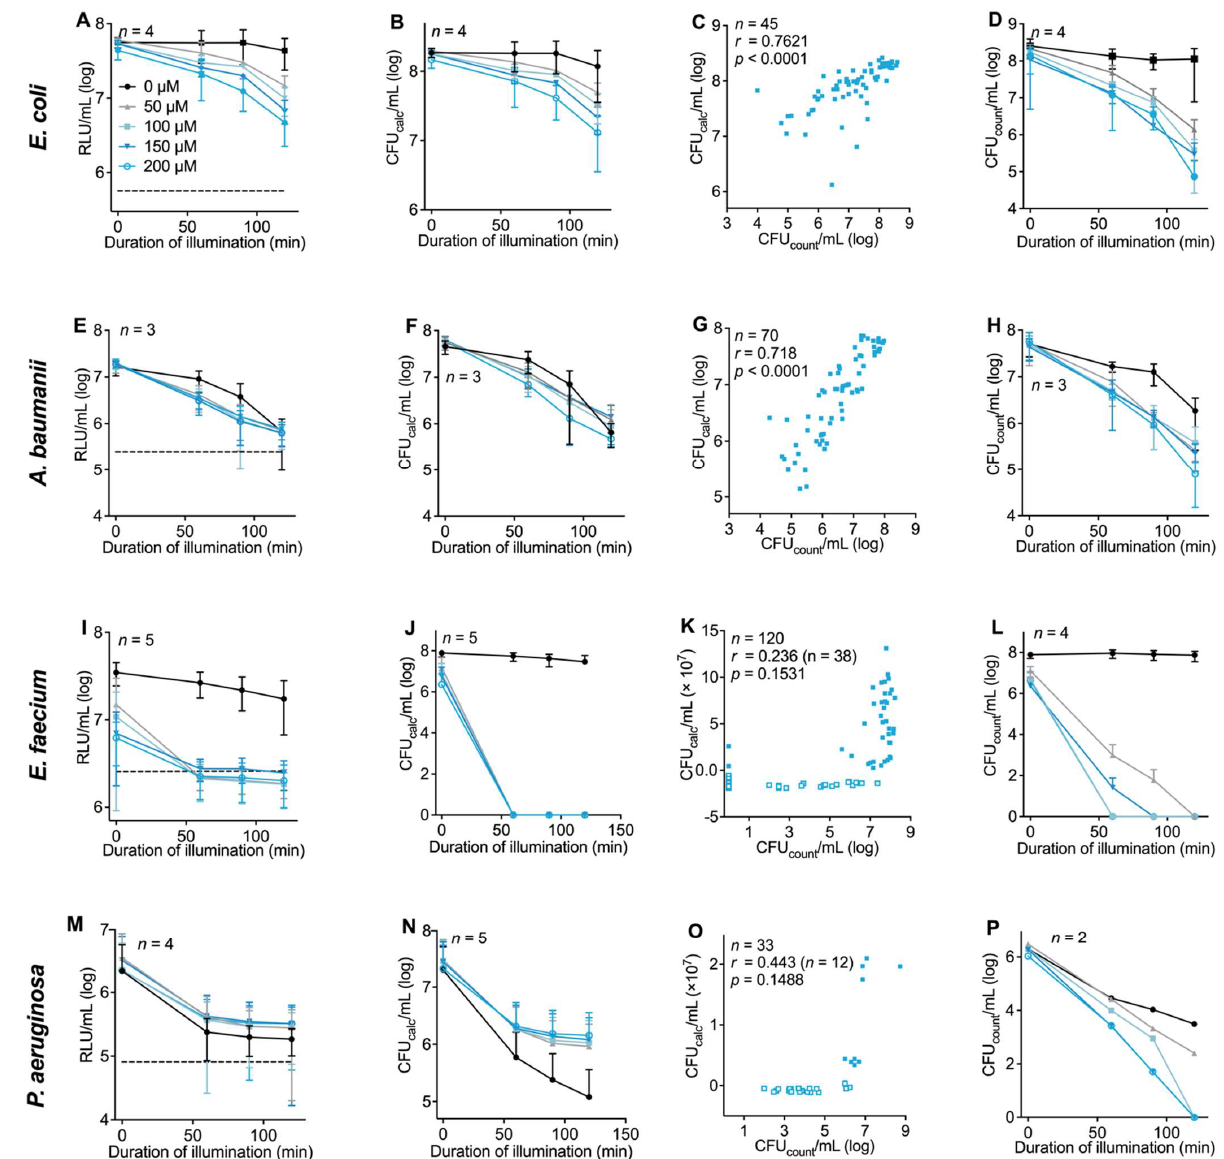
Figure 4. Evaluation of aPDI effects of TMPyP on different bacterial strain as determined by ATP-evoked luminescence and manual counting of bacteria colonies. Data from the aPDI experiments are presented. TMPyP at indicated concentrations was illuminated with 13 mW/cm 2 resulting in 0 J/cm 2 (0 min), 46.8 J/cm 2 (60 min), 70.2 J/cm 2 (90 min), 93.6 J/cm 2 (120 min) at λ cent = 420 nm; the dashed line shows the luminescence of heat-inactivated bacteria. ( A ) ATP-induced luminescence of ESBL E. coli after aPDI. ( B ) Calculated bacterial density (CFU calc ) of ESBL E. coli based on luminometric measurements. ( C ) Correlation between CFU calc and manually determined bacterial density (CFU count ) in ESBL E. coli ; r = correlation coefficient. ( D ) CFU count of viable ESBL E. coli after aPDI. ( E – H ) Results for XDR A. baumanii as described above for E. coli . ( I – L ) Results for VRE E. faecium; cal-